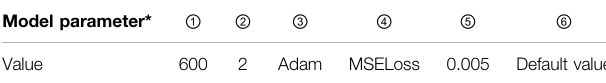
TABLE 2 | LSTM model parameter settings. Model parameter*